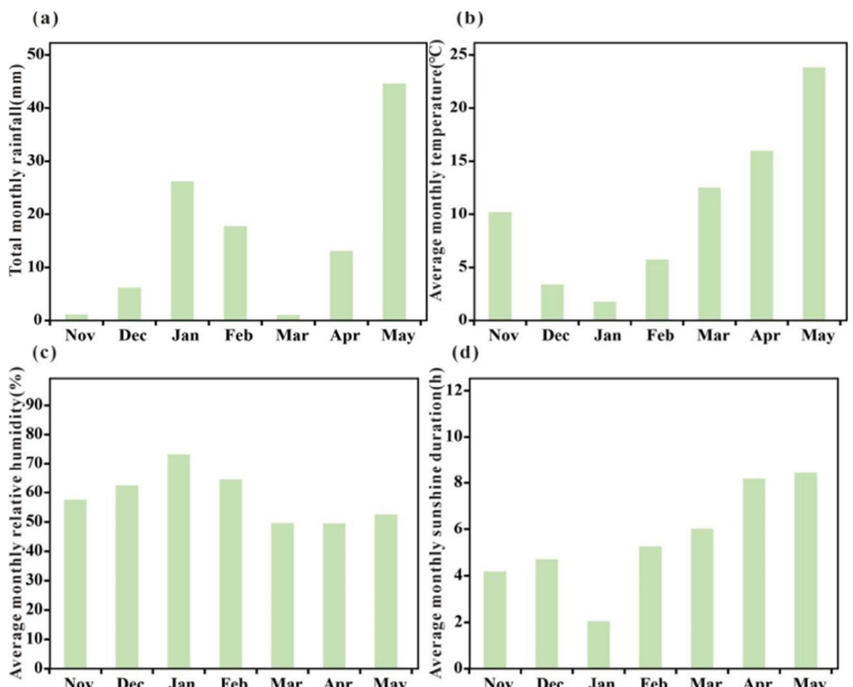
Figure 1. Meteorological conditions during the wheat growth period from November to May: ( a ) total monthly rainfall, ( b ) average monthly temperature, ( c ) average monthly humidity, and ( d ) average monthly sunshine